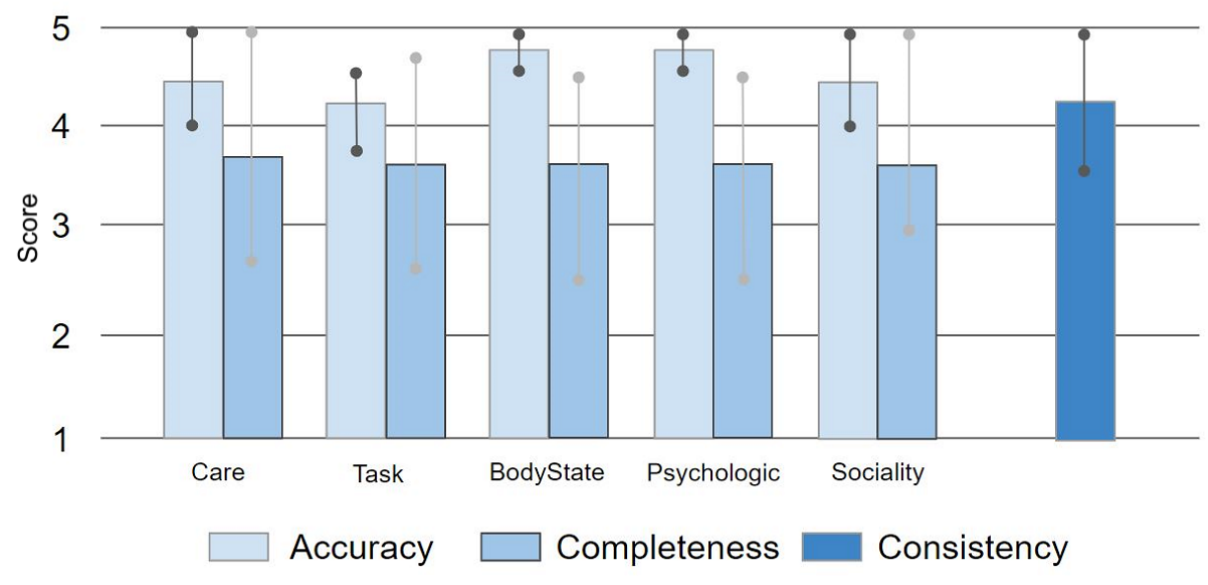
Figure 8. Evaluation of the care knowledge assessed by care experts in